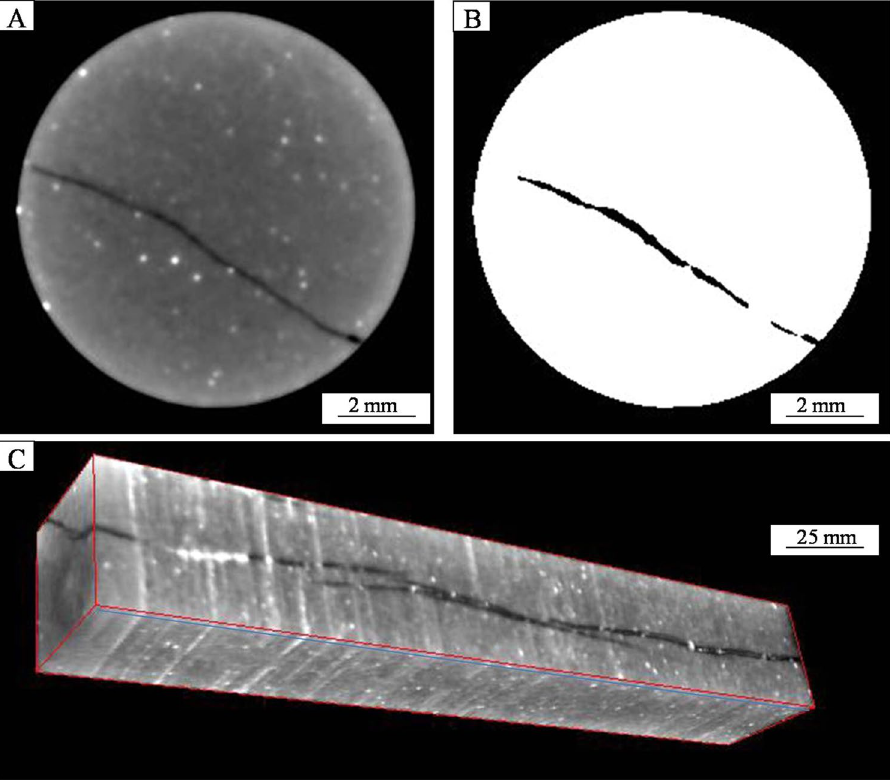
Figure 1. Example of ICT 2D slices ( A,B ) and the reconstructed 3D volume ( C ) by a stack of contiguous